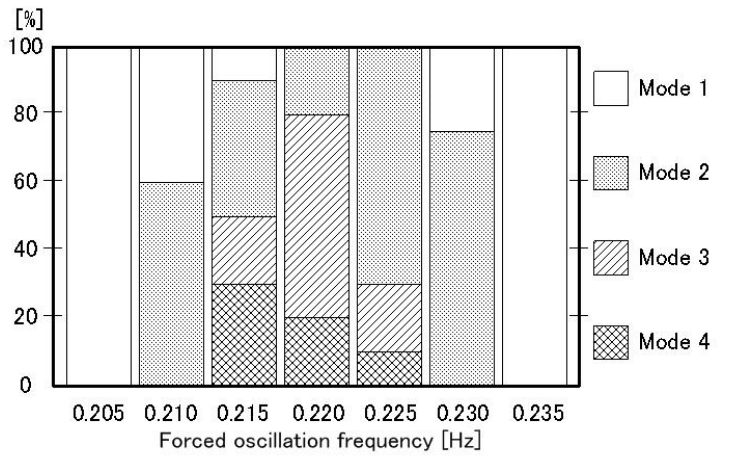
Fig.5 Appearance time rate of probability distributions for each forced oscillation